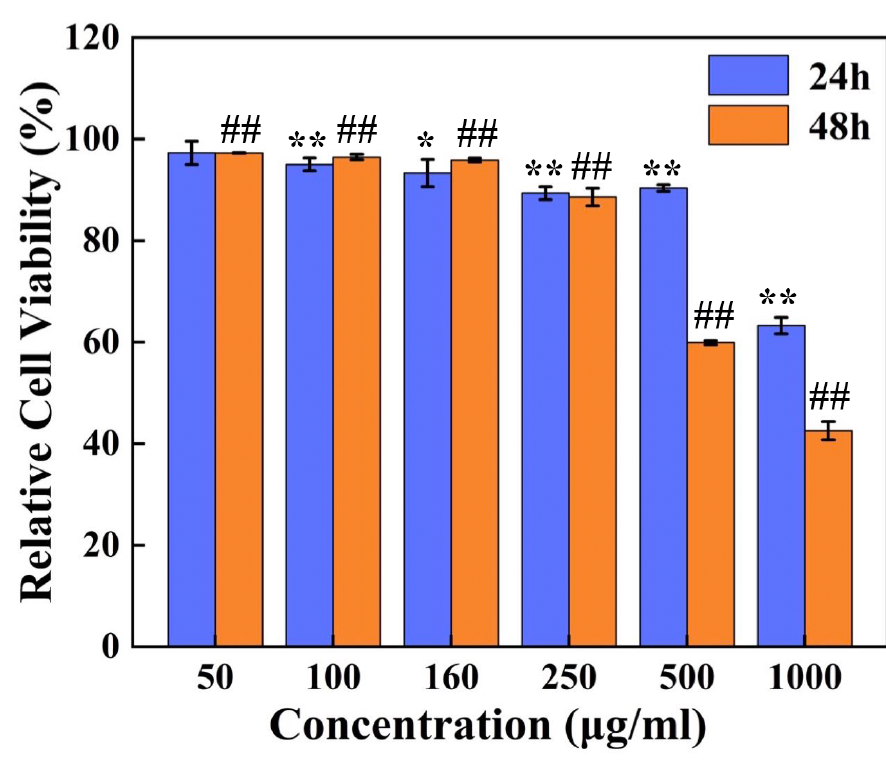
Figure 3. Cell viability of L929 cells incubated with GQD-NPs. The experiments were carried out in triplicate. Data were presented as mean ± standard deviation (SD) ( n = 3). The cell viability values were all normalized to control groups (untreated cells after incubation for 24 h or 48 h). Asterisk (*) and double asterisks (**) refer to statistical significance of p < 0.05 and p < 0.01, respectively, compared with control groups between the cell viability values after co-incubation for 24 h; double pounds (##) refer to a statistical significance of p < 0.01 compared with control groups between the cell viability values after co-incubation for 48 h.